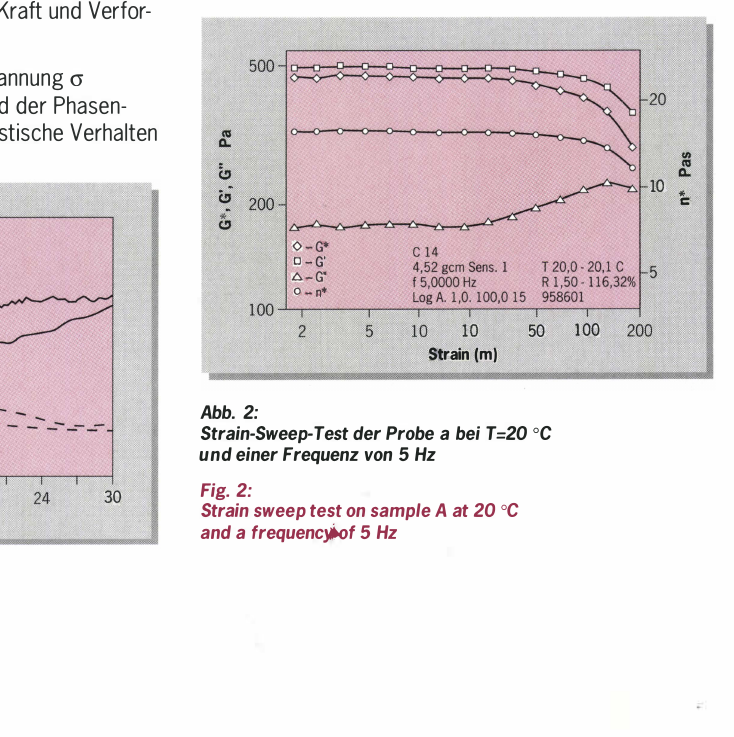
Fig. 1: Flow curve for sample A at 20 oc